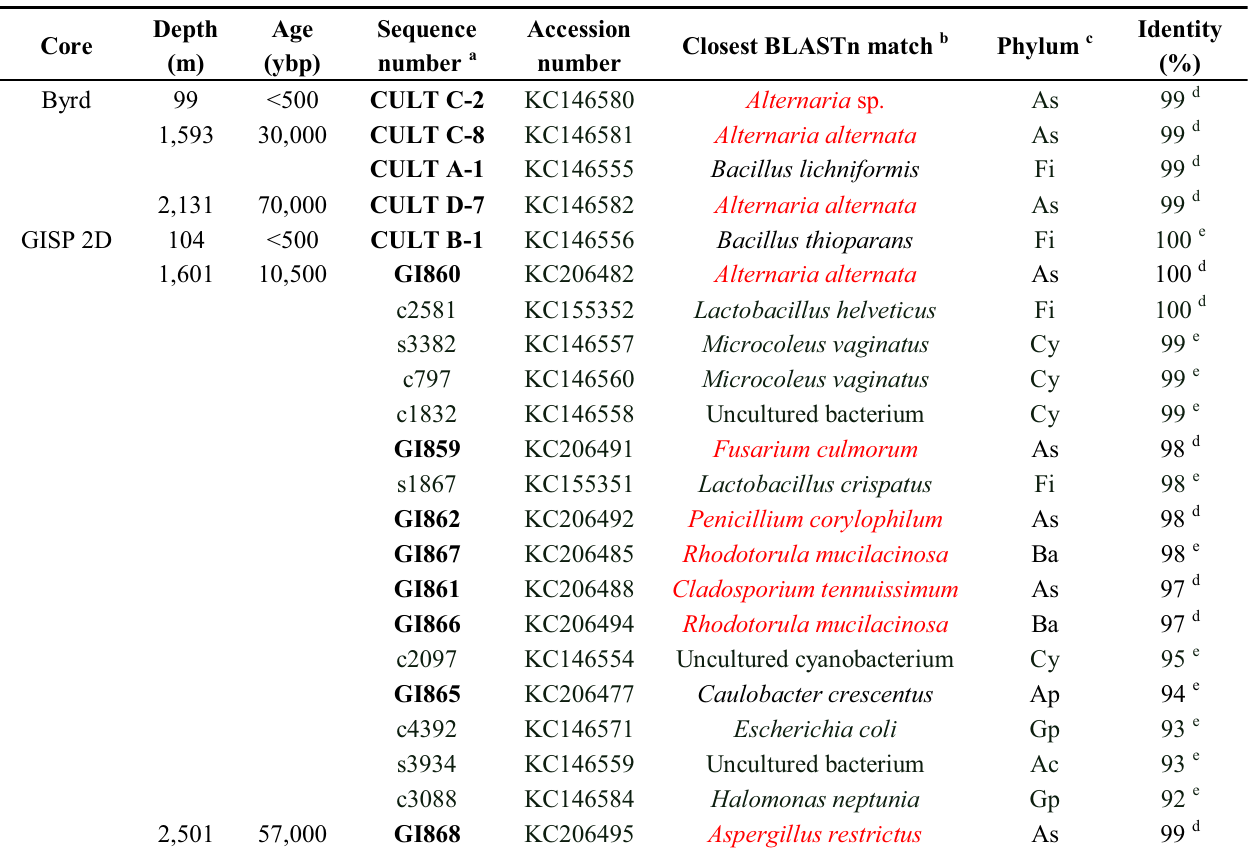
Table 1. Summary of BLAST search results. Included are sequences from cultures and metagenomic/metatranscriptomic